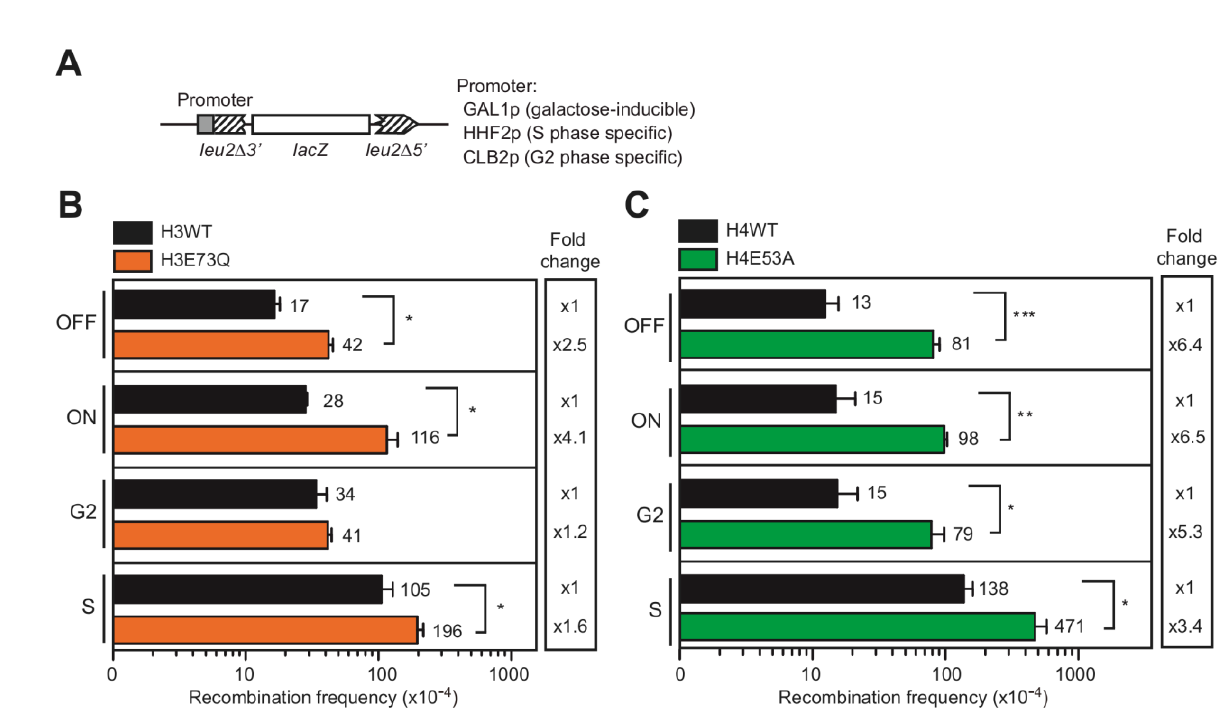
FIGURE 3: Hyper-recombination phenotype of H3E73Q and H4E53A mutants is not associated with defective transcription. (A) A scheme of the direct-repeat recombination system with different promoters is shown. GAL1 promoter ( GAL1p ) is induced in 2% galactose (ON) and repressed in 2% glucose (OFF). Transcription from CLB2 promoter (CLB2p) is restricted to G2 phase. Transcription from HHF2 promoter (HHF2p) is restricted to S phase. (B) Analysis of direct-repeat recombination frequencies in H3 wild-type (H3WT) and H3E73Q (H3E73Q) strains transformed with pARSLlacZGLB-in, pARSLlacZHLB-IN or pARSLlacZBLB plasmids with the direct-repeat recombination system under GAL 1, HHF2 , CLB2 promoter respectively (n=3). (C) Analysis of direct-repeat recombination frequencies in H4 wild-type (H4WT) and H4E53A (H4E53A) strains transformed with pARSLlacZGLB-in, pARSLlacZHLB-IN or pARSLlacZBLB plasmids with the direct-repeat recombination sys- tem under GAL1 , HHF2 , CLB2 promoters, respectively (n=3). Means and SEM are plotted in (B) and (C). *p ≤ 0.05, **p ≤ 0.01, ***p ≤ 0.001 (two- tailed Student’s t